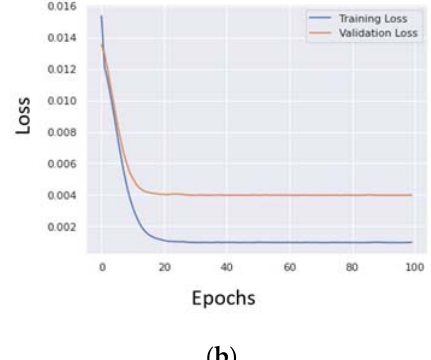
Figure 6. Beat-to-beat separation of the ( a ) testing data collected from the ambulatory sensor (Savvy ECG); ( b ) training data derived from the MIT-BIH database; ( c ) NSR testing data taken from the INCART database; ( d ) PVC training and testing data from the INCART database; ( e ) NSR testing data from the LTAFDB database. (x-axis: sequential time value index; y-axis: ECG voltage measured in millivolts (mV)).